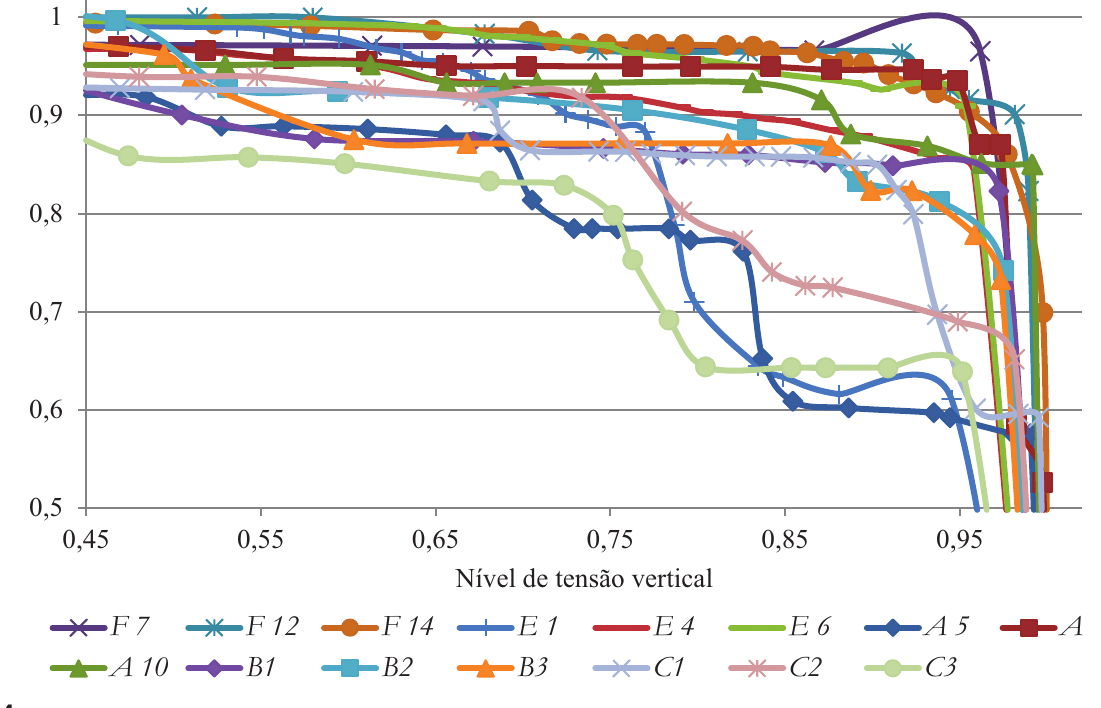
Resumo do comportamento da onda longitudinal em amostras de concreto submetidas à compressão